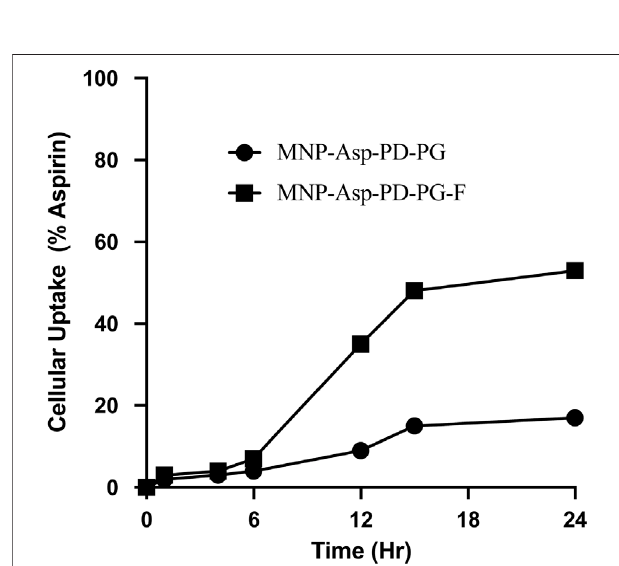
FIGURE 6 | Cellular uptake assay of MCF-7 breast cancer cells examinedat2,4,6,12,15,and24 h;cellcultureistreatedwithdrug-loadedin Aspirin loaded MSNs prepared in this study (MNP-Asp@PD-PG and MNP-